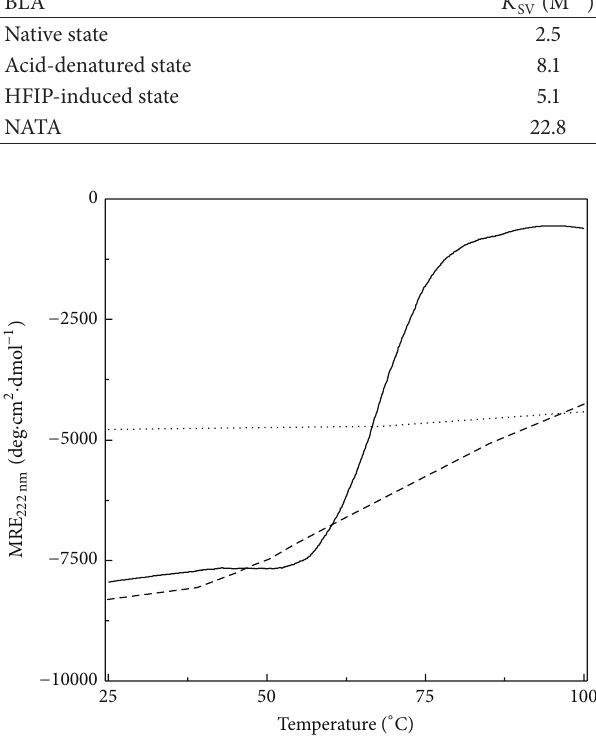
Figure 5: Temperature dependence of the far-UV CD spectral of different conformational states of BLA. Native signal, MRE 222 nm state (—), acid-denatured state ( ⋅ ⋅ ⋅ ), and HFIP-induced state